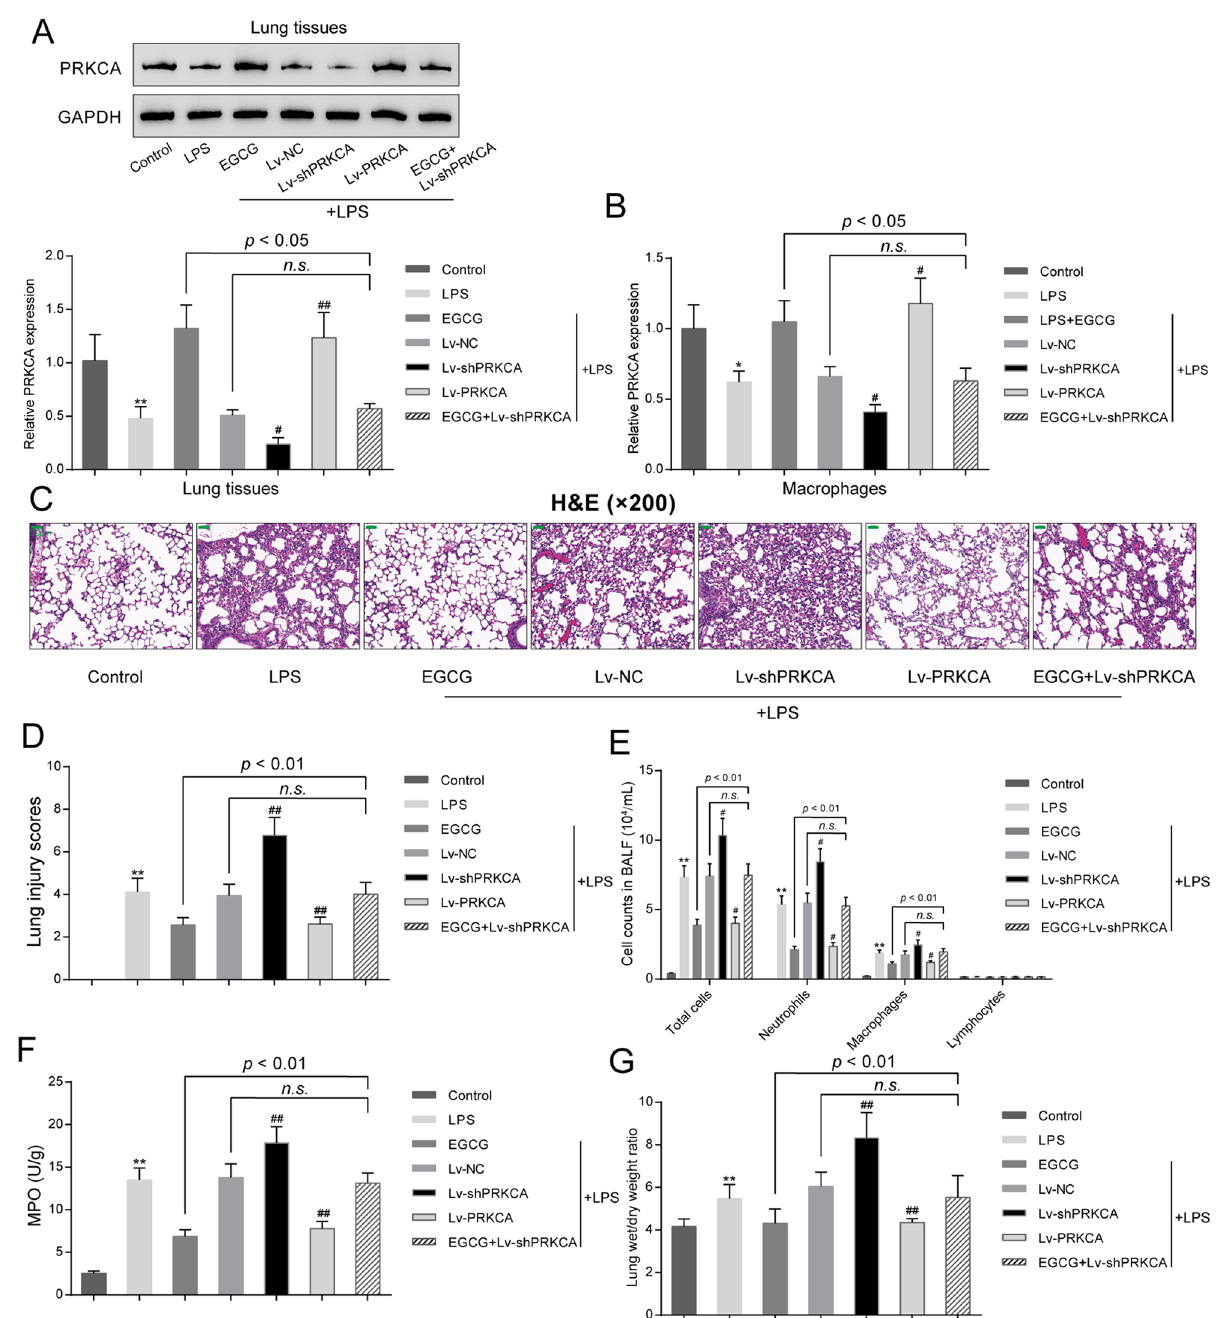
Figure 4. Effects of PRKCA on LPS-induced ALI. Mice were randomly divided into seven groups: the control group, the LPS group, the LPS + EGCG, the LPS + Lv-NC group, the LPS + Lv-shPRKCA group, the LPS + Lv-PRKCA group, and the LPS + EGCG + Lv-shPRKCA group. Mice in each group received treatment and/or injection accordingly. ( A ) PRKCA mRNA and protein expression levels in lung tissues of mice from each group was determined using real-time qPCR and Immunoblotting; ( B ) PRKCA expression levels in alveolar macrophages of mice lung from each group were determined using real-time qPCR; ( C ) pathological changes using H&E staining (200 ×). scale bar = 50 μm; ( D ) lung injury scores following the methods reported before; ( E ) cell numbers including total cells, neutrophils, macrophages and lymphocytes using a hemocytometer; ( F ) MPO activity using a spectrophotometer; ( G ) lung wet/dry weight ration. * P < 0.05, ** P < 0.01, compared to the control group. # P < 0.05, ## P < 0.01, compared to the LPS + Lv-NC